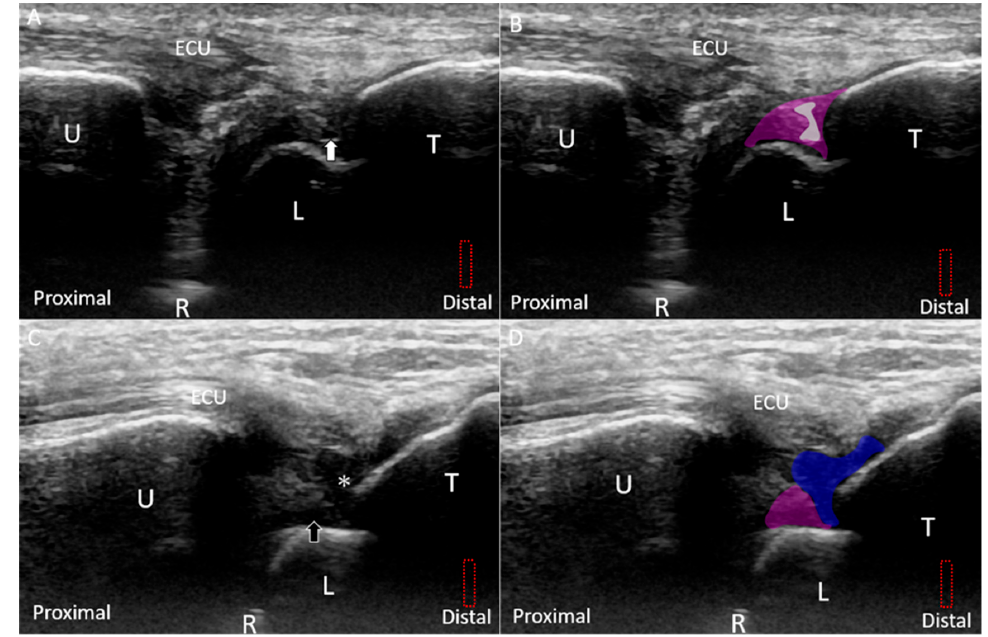
radioulnar ligaments and central tear of the articular disc (white arrowhead) using the ( E ) long ‐ axis and ( F ) short ‐ axis views. All lesions are categorized under Class 1E injuries. The different color dashed rectangles are in accordance with the transducer positions in Figure 3. US: ultrasound; black arrow: avulsed bony fragment from the radius; U: ulna; R: radius; L: lunate; T: triquetrum; EPL: extensor pollicis longus; EDC: extensor digitorum communis; EDM: extensor digiti minimi; ECU: extensor carpi ulnaris .